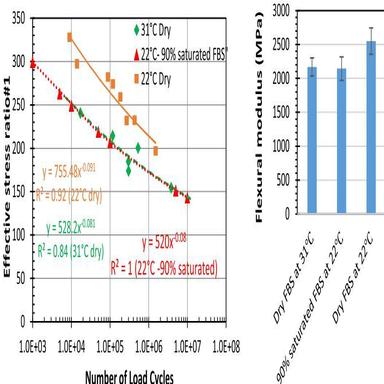
Performance comparison of 90% saturated FBS specimens (3% bitumen + 2% lime) at 22 ℃ and FBS specimens dried at 31 ℃: a.) Flexural fatigue life b.) Flexural modulus.